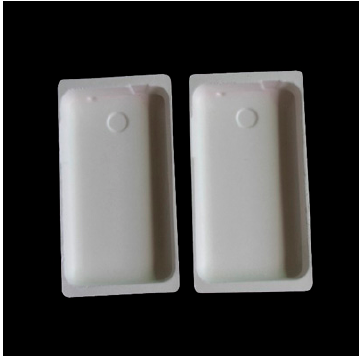
Figure 18. Mobile box made of natural fibres [119].